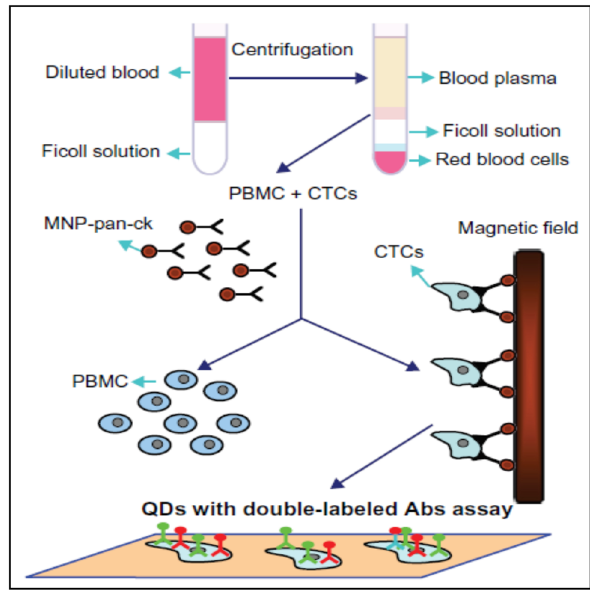
Figure 7: Schematic presentation of recognition and separation of tumor cells using MNP - coupled pan cytokeratin antibody and QDs with double - labeled antibody [ 196 ] ( PBMC: peripheral blood mononuclear cells ) . Reprinted ref. [ 196 ] under Creative Common License.